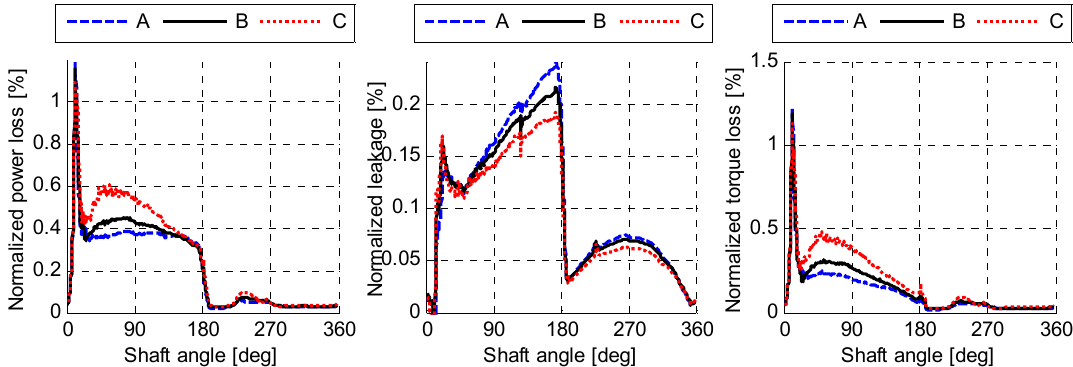
Figure 13. Normalized piston/cylinder interface performance comparison for different sizes.